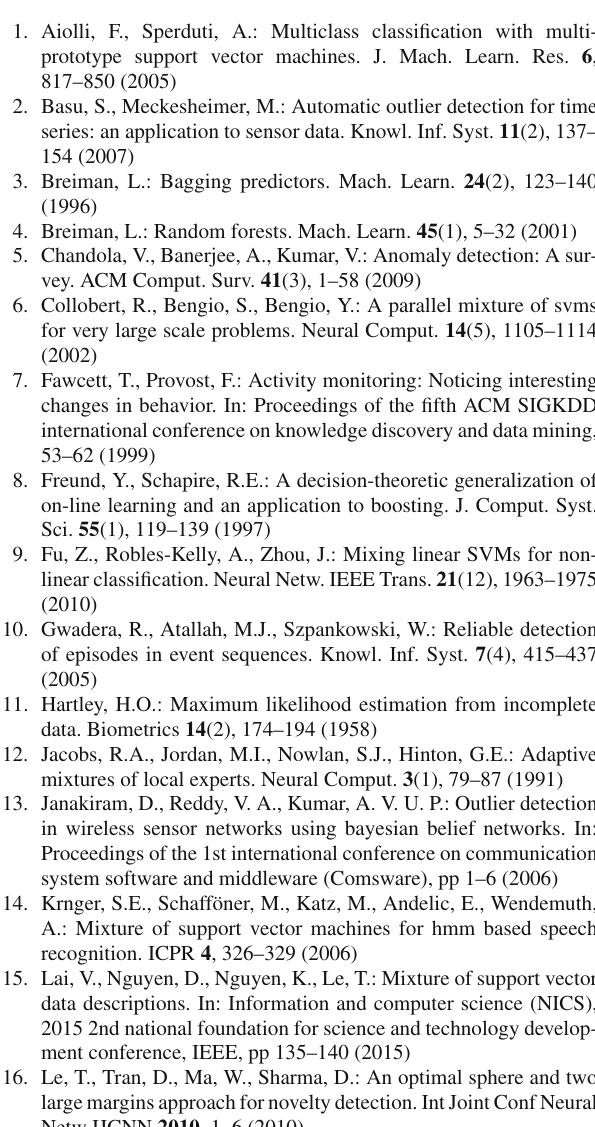
the component hypersphere tends to be smaller and would not give a very high probability to data located inside the hypersphere and near the boundary. This prevents the model from misclassifying abnormal data points, but have the side effect of increasing the misclassification of normal